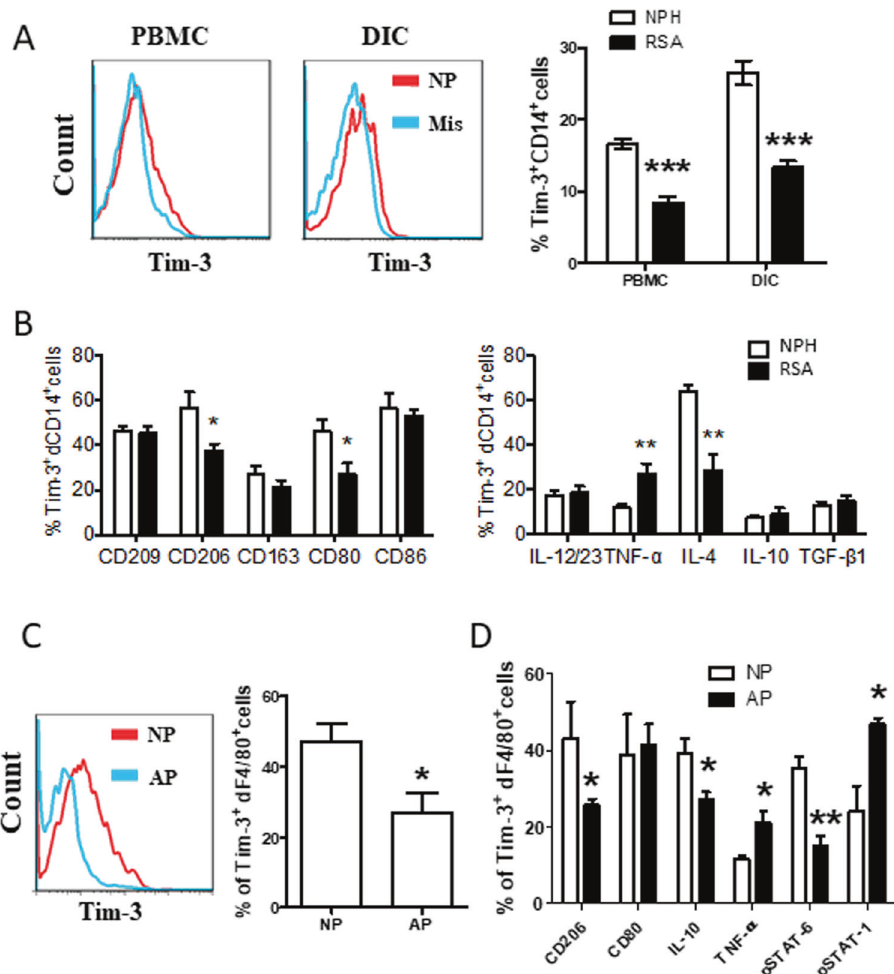
Fig. 2 Decreased cell number of Tim-3 + CD14 + cells with de fi cient function in miscarriage. A Frequency of Tim-3 expressing cells in gated CD14 + cells of paired PBMCs and DICs from normal pregnant subjects (NPH, normal pregnancy of human, n = 40) and patients who diagnosed as recurrent spontaneous abortion (RSA, n = 40) as determined by fl ow cytometric analysis. A representative dot plot is also shown. B Surface molecule expression and cytokine production by Tim-3 + decidual CD14 + (Tim-3 + dCD14 + ) cells from normal pregnancy and RSA was assessed by fl ow cytometric analysis. Data represent the mean ± SEM. * P < 0.05, ** P < 0.01. NPH: normal pregnancy of human, RSA: recurrent spontaneous abortion. C Frequency of Tim-3 expressing cells in gated F4/80 + cells from DICs of normal pregnant (NP, n = 17) and abortion-prone (AP, n = 18) mice. A representative dot plot is also shown. D Quanti fi cation of fl ow cytometric analysis of surface molecule expression and cytokine production by Tim-3 + dF4/80 + cells from NP ( n = 5) and AP ( n = 4) mice. Data represent the mean ± SEM. * P < 0.05, ** P < 0.01, *** P < 0.001. NP: normal pregnancy, AP: abortion prone. Data are representative of 4-5 independent analyses. * P < 0.05, ** P <